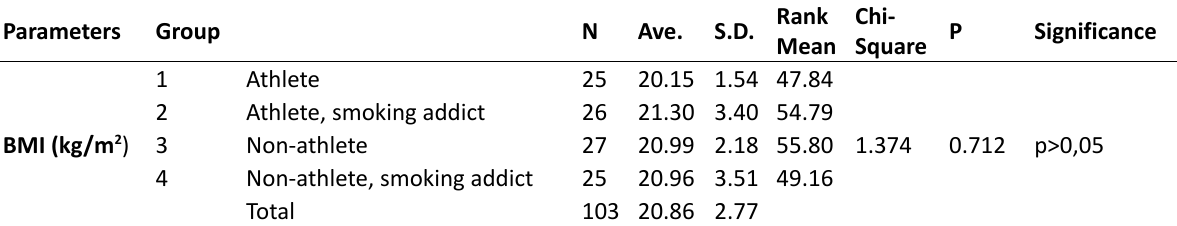
Table 1. BMI values of female university students Parameters